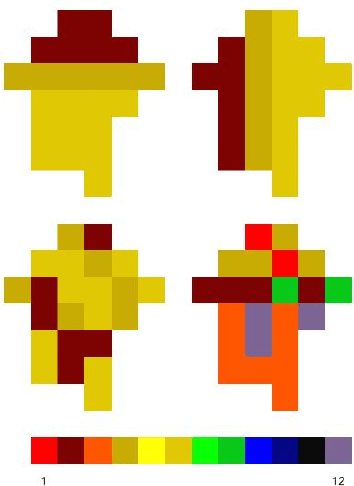
Figure 1. Hypothetical FFCO2 mass maps for a hypothetical coun- try. The total mass of emissions is identical in the four panels; only the spatial distribution has changed between the panels. This paper aims to aid in the evaluation of such maps by supplying gridded un- certainty information at the same spatial and temporal scales as the emission maps. The scale is in arbitrary